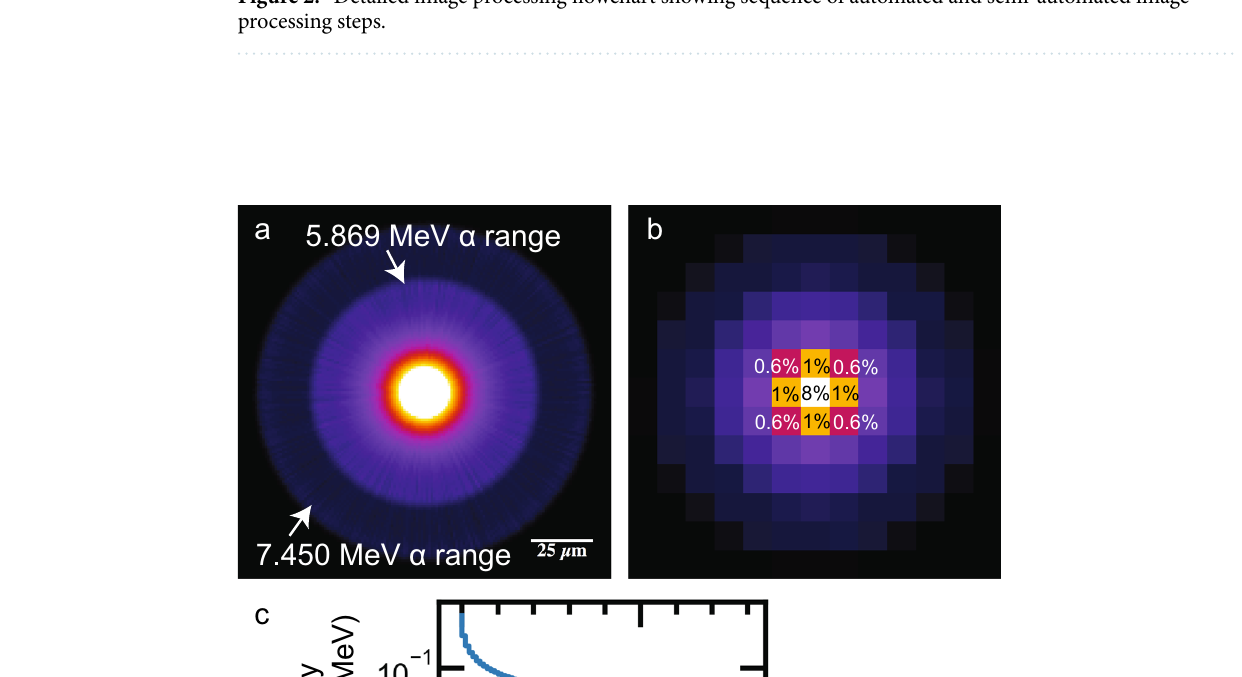
Figure 2. Detailed image processing flowchart showing sequence of automated and semi-automated image processing steps.